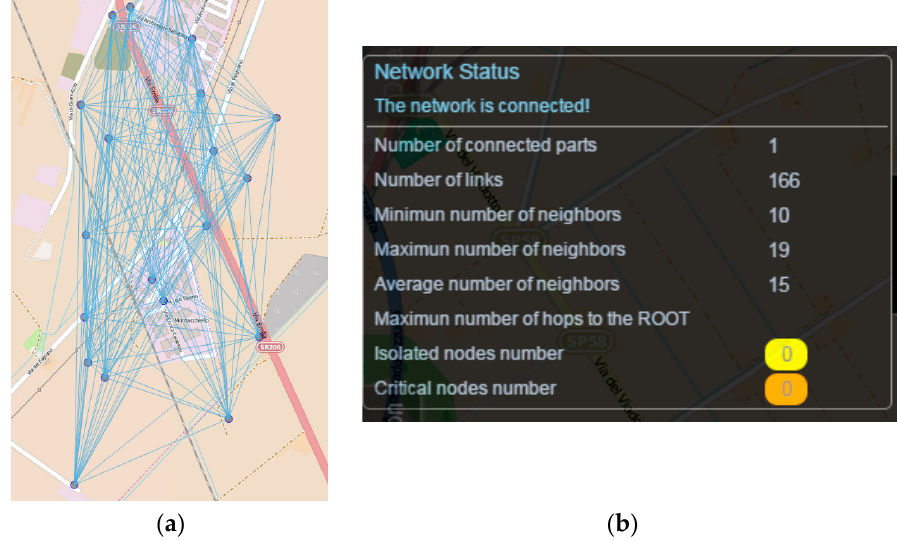
Figure 7. WSN-DPCM Integrated Network Evaluation Algorithms results: graphical ( a ) and statistics ( b ). Alternative Reduced Topology Indication